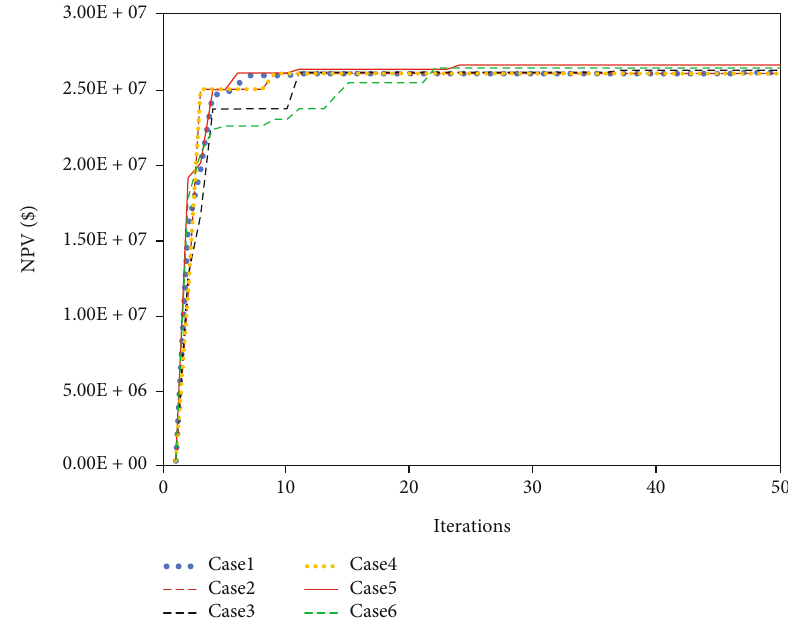
Figure 5: The NPV with respect to number of iteration based on six cases.